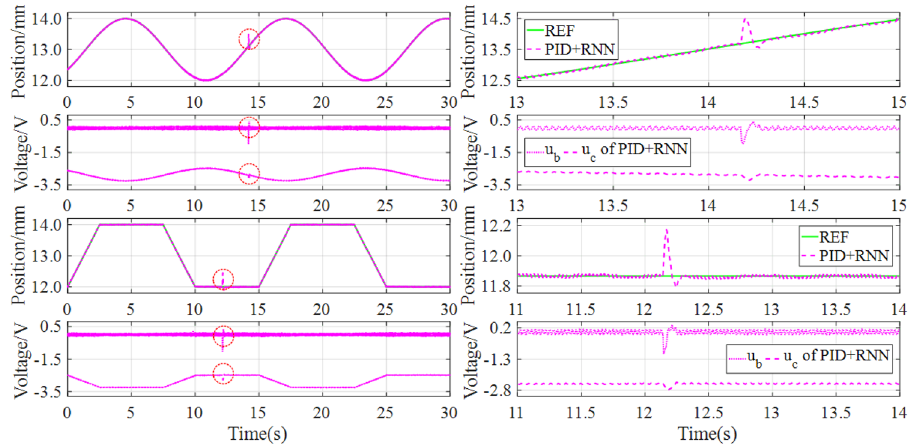
Figure 16. Experiment results of disturbance suppression under sinusoidal and trapezoidal signals.